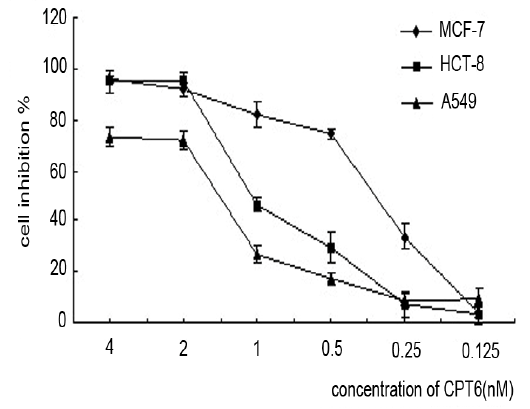
Figure 2. The inhibitory effects of three cell lines treated with CPT6 for 72 h. The experiments were performed in triplicate. Data are presented as mean ± SD of three independent experiments.